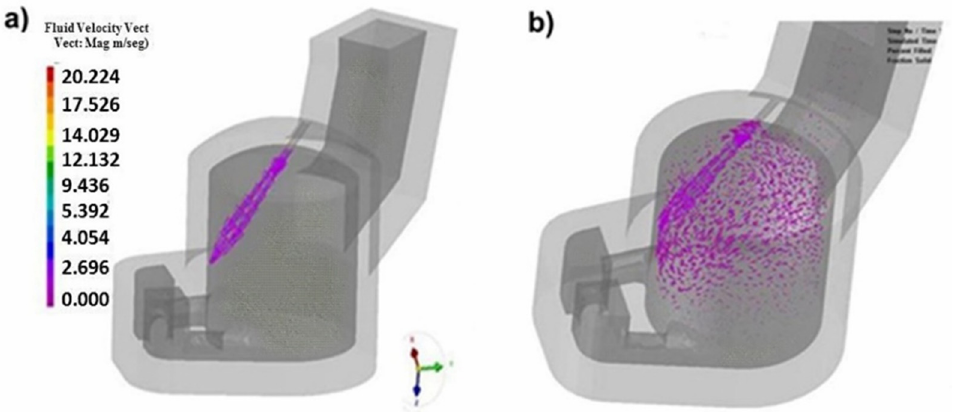
Figure 6. ( a ) Velocity vectors in the main chamber just initiating the melting cycle; ( b ) velocity vectors acquired for a simulation time of 4800 s.